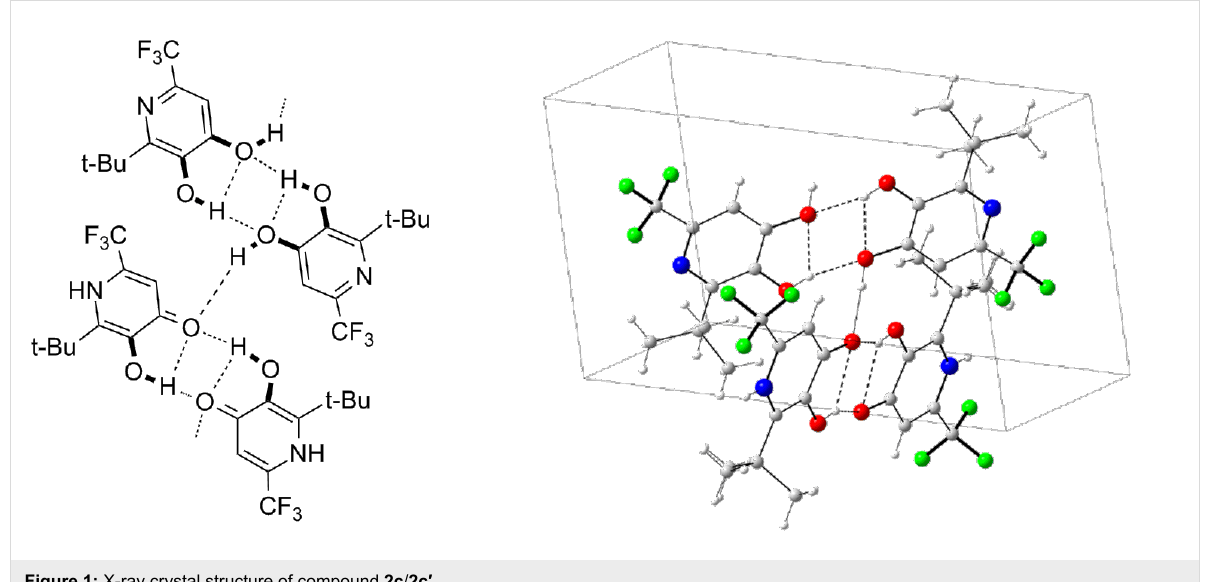
Figure 1: X-ray crystal structure of compound 2c / 2c ′